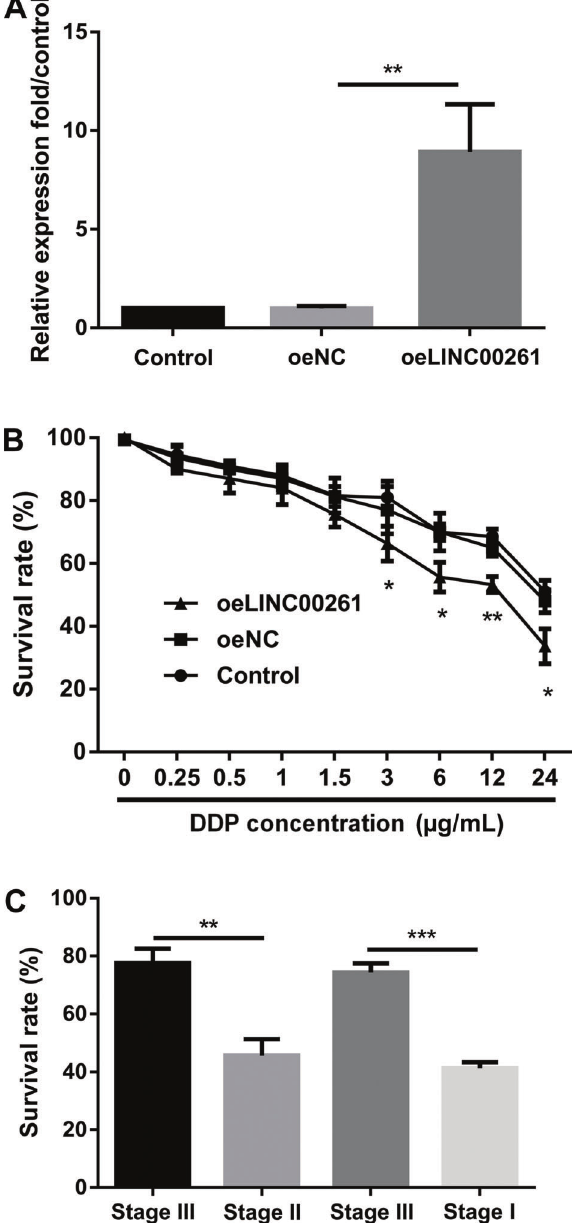
Figure 3. Effects of LINC00261 on cisplatin (cis-diammineplati- num dichloride, DDP) resistance of cells. A , LINC00261 was